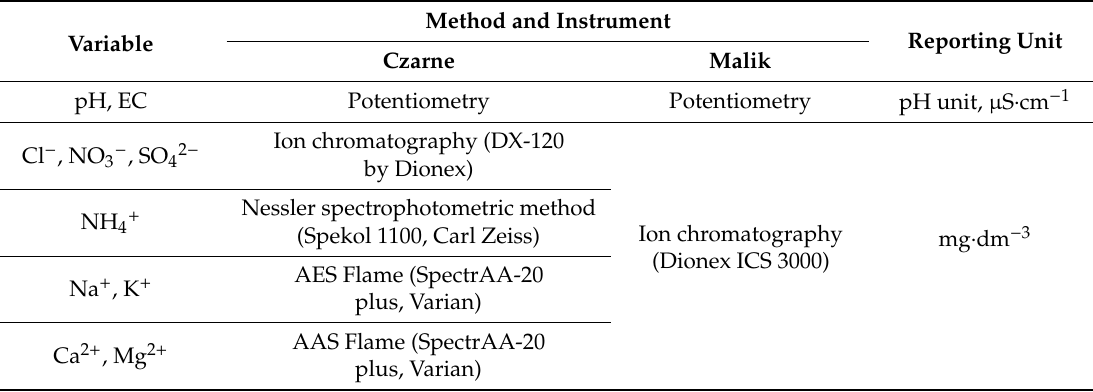
Table 2. Experimental parameters, methods, and